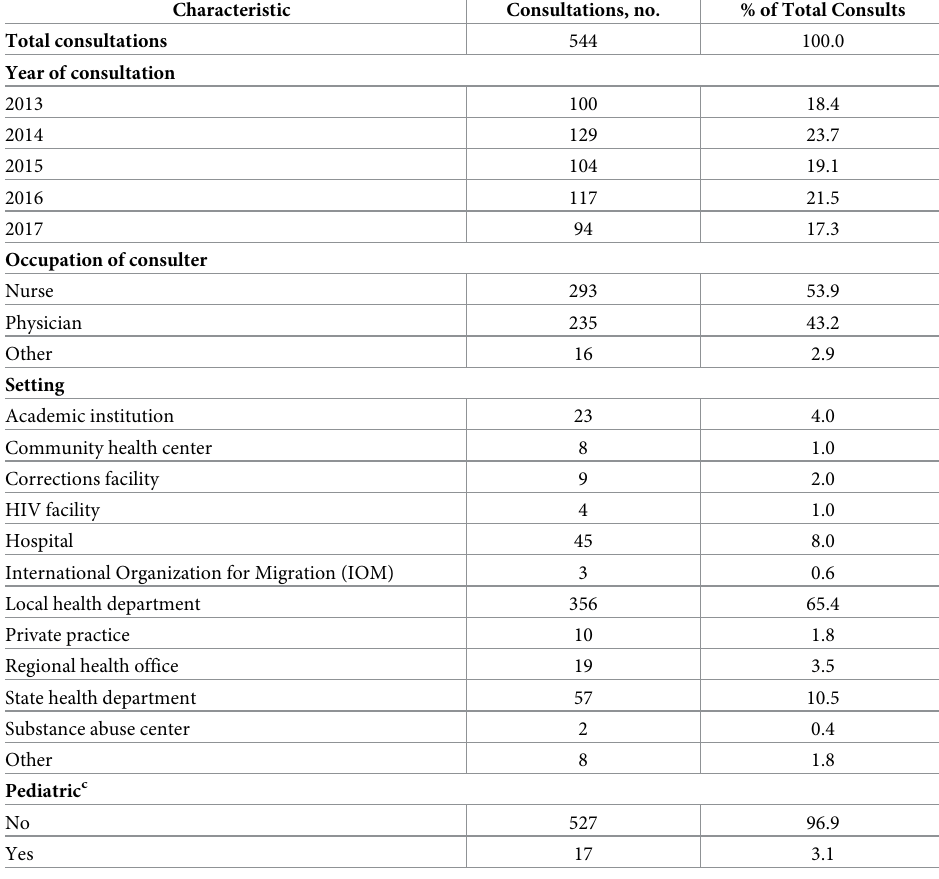
Table 1. Summary of TB/HIV consultations a provided by all Regional Training and Medical Consultation Centers (RTMCCs) b ,